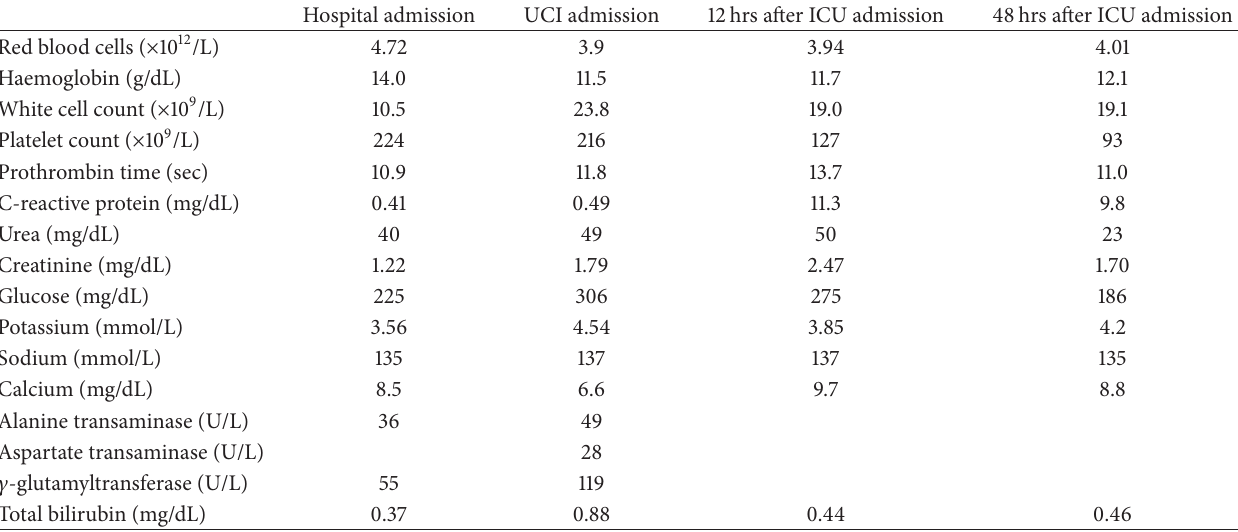
Table 1: Laboratory data.